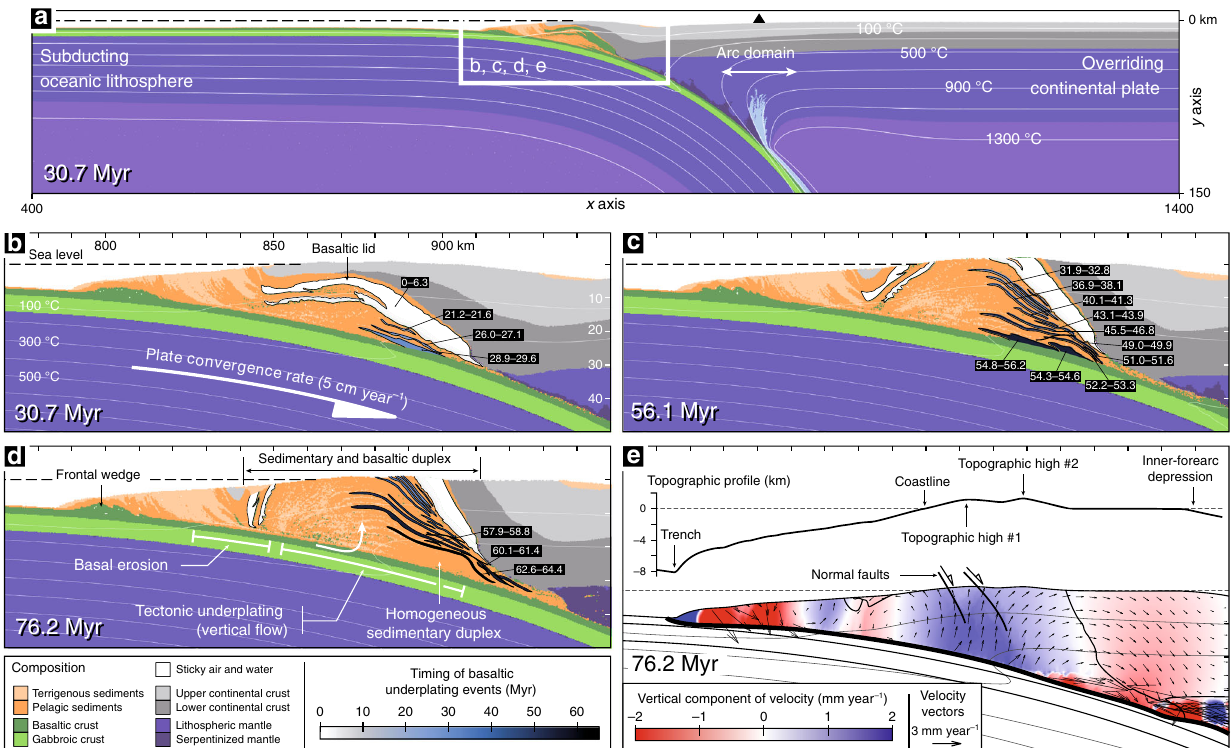
Fig. 2 Tectonic underplating, duplex formation and long-term topography. a Compositional map showing an overview of the reference ocean-continent subduction model. b – d Compositional maps focusing on the forearc domain where tectonic underplating of sedimentary and basaltic material is achieved by an overall vertical fl ow (thick white arrow). Once inserted in the duplex, basaltic slices resulting from regularly time-spaced stripping events are highlighted with white-to-blue colours depending on the timing of basal accretion (black boxes; time in Myr). e Velocity map (vertical component only) of the forearc domain during a discrete underplating event. Red and blue colours represent downward and upward vertical displacements, respectively. Black arrows depict the calculated global velocity fi eld. The modelled topographic pro fi le across the forearc domain is depicted with a 2.5 vertical